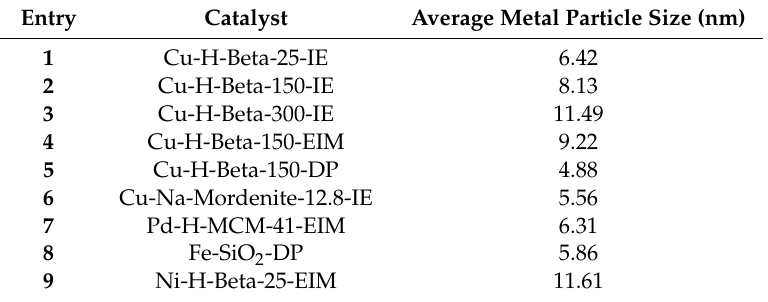
Table 1. Cu, Pd, Fe Sn, Ni particle size average of Cu-H-Beta-25-IE, Cu-H-Beta-150-IE, Cu-H-Beta-300-IE, Cu-H-Beta-150-EIM, Cu-H-Beta-150-DP, Cu-Na-Mordenite-12.8-IE, Pd-H-MCM-41-EIM, Fe-SiO 2